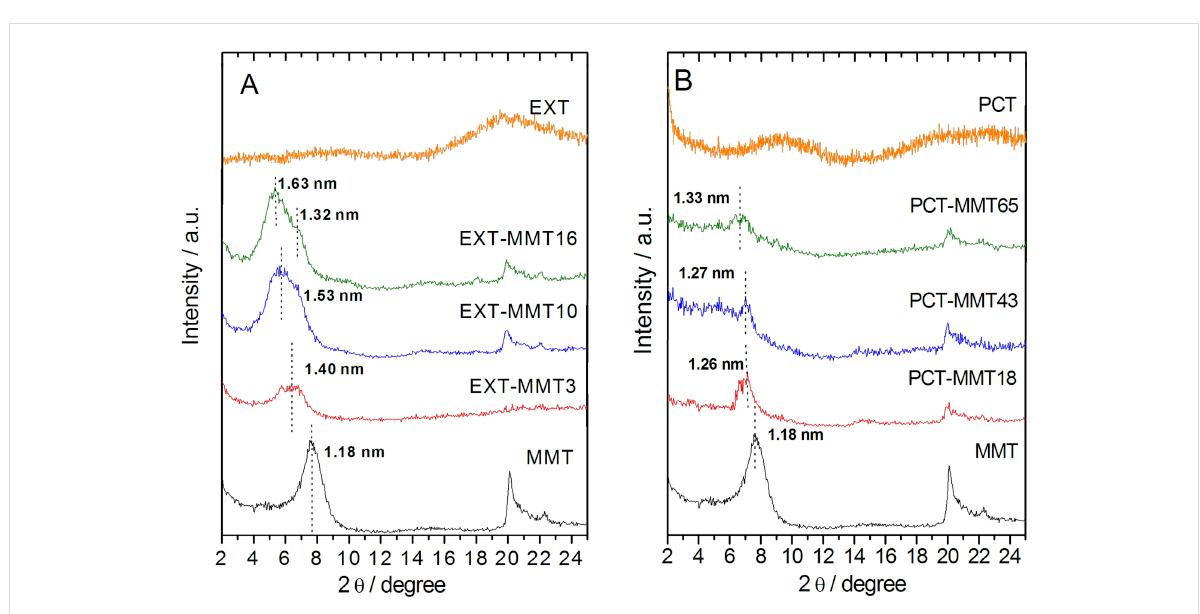
Figure 5: XRD patterns of the biohybrids prepared from (A) the extracted (EXT) and (B) the precipitate (PCT) fractions separated from different amounts of zein in pure ethanol.